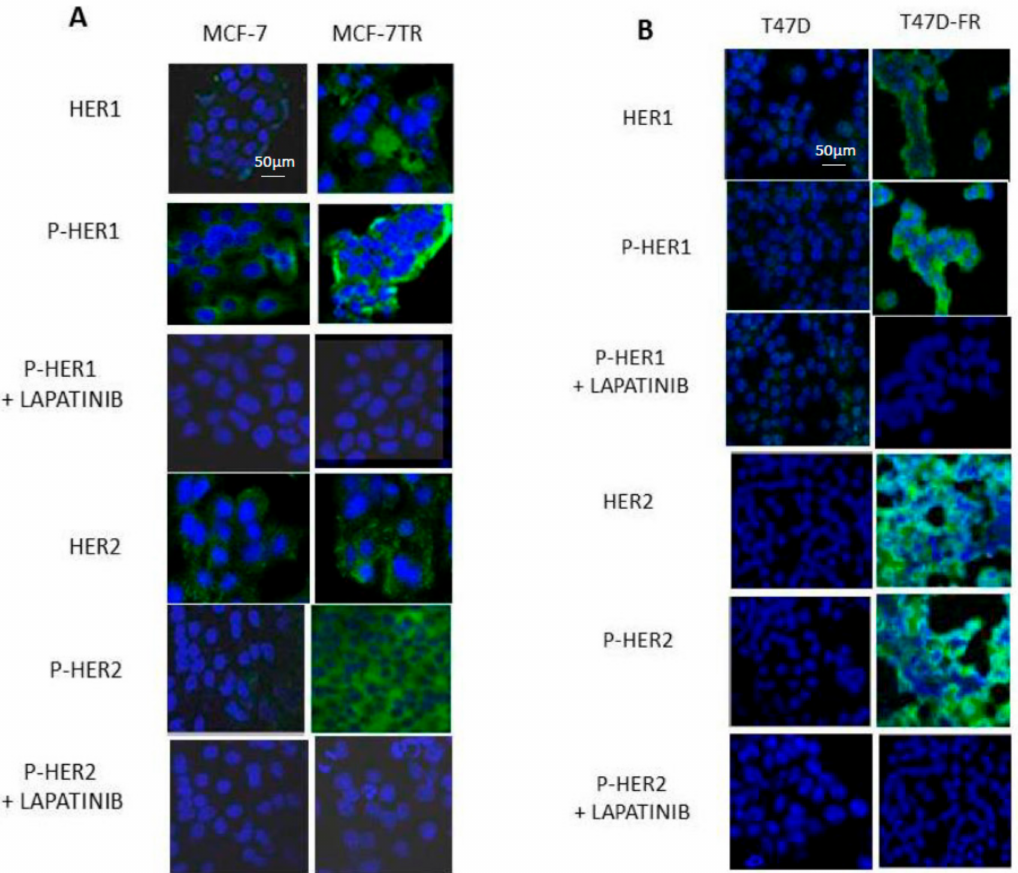
Figure 4. HER1 and HER2 expression with and without tyrosine kinase inhibitor (TKI) treatment in parental MCF-7 and MCF-7-TR (tamoxifen-resistant) and T47D and T47D-FR (fulvestrant-resistant) breast cancer cell lines using confocal fluorescence microscopy. Cells were treated with 5 µ M lapatinib and incubated for 48 h. TO-PRO-3 (blue) was used to label nuclei, and HER1 ( A ) and HER2 ( B ) antibody reactions were conjugated to Alexa-Fluor 488 secondary antibody. Images are representative of at least three separate experiments. Settings for the microscope were maintained as consistently as possible from one experiment to